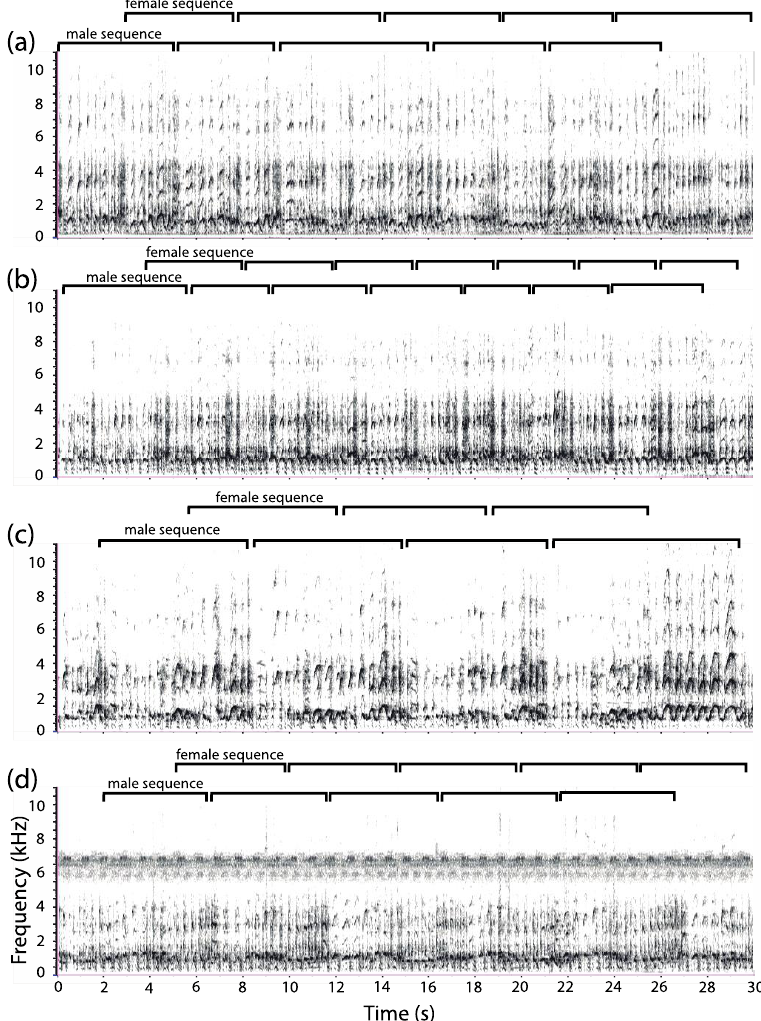
Figure 5. Joint emissions displayed on a larger time scale. ( a ) P. donacophilus, ( b ) P. pallescens, ( c ) P. modestus, and ( d ) P. olallae. Time and frequency scales have been adjusted to match the spectrograms representative of the moloch lineage in Figure 6. Putative male and female sequences begin at the onset of the pant phrase produced by each sex, respectively. The spectrogram of P. olallae shows noisy insect sounds in the 6 to 7 kHz frequency band.